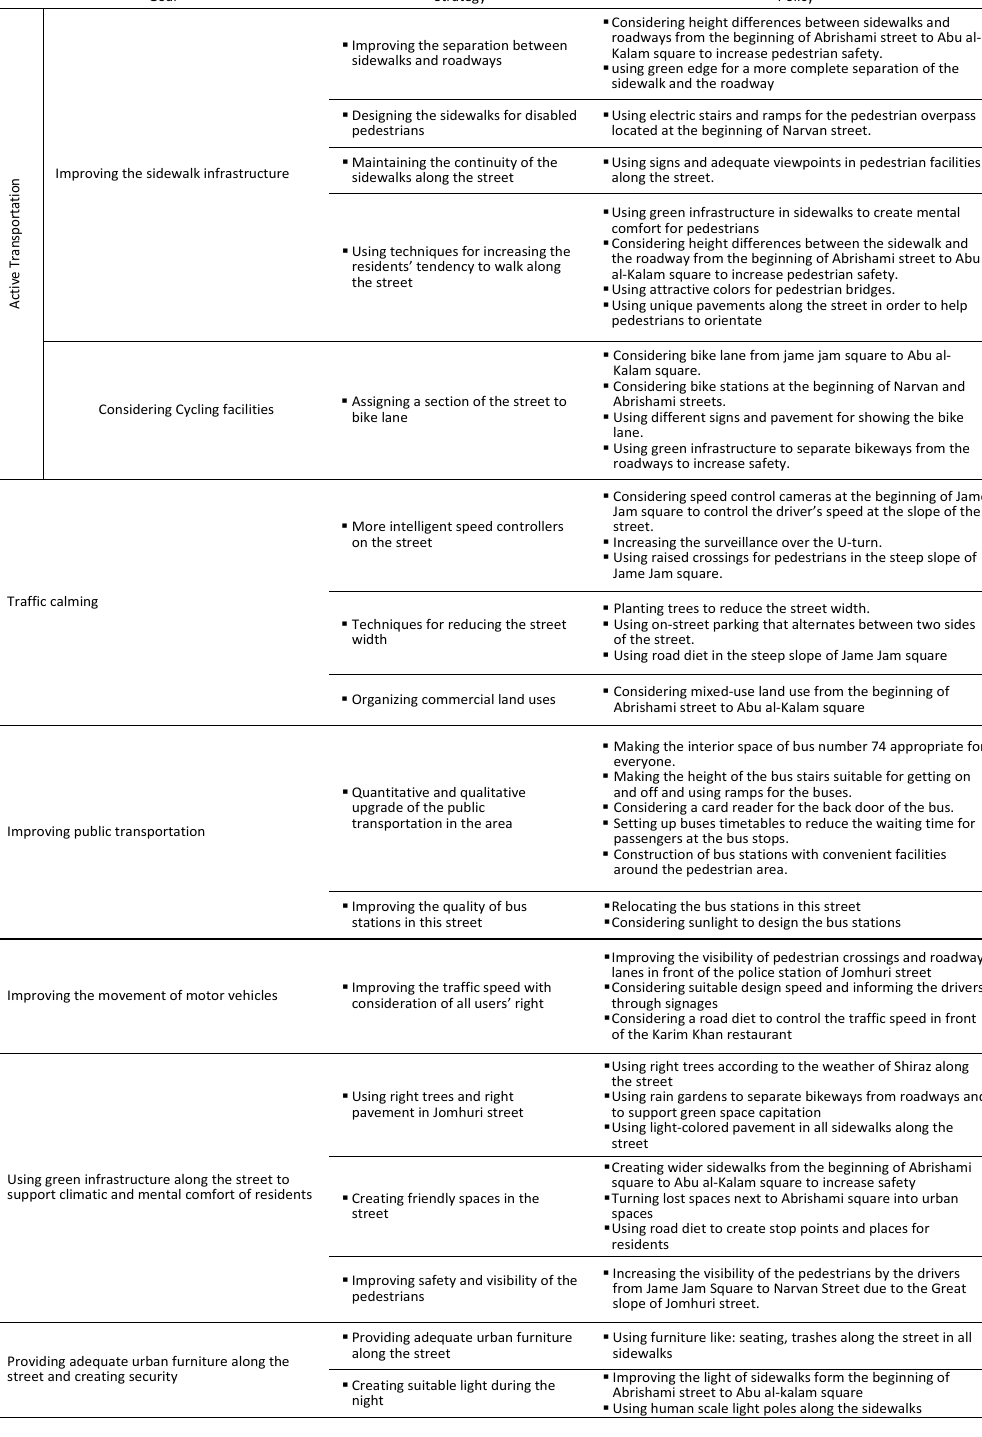
Table 3: Strategies and Policies Proposed for Jomhuri Street Table 3. Strategies and Policies Proposed for Jomhuri Goal